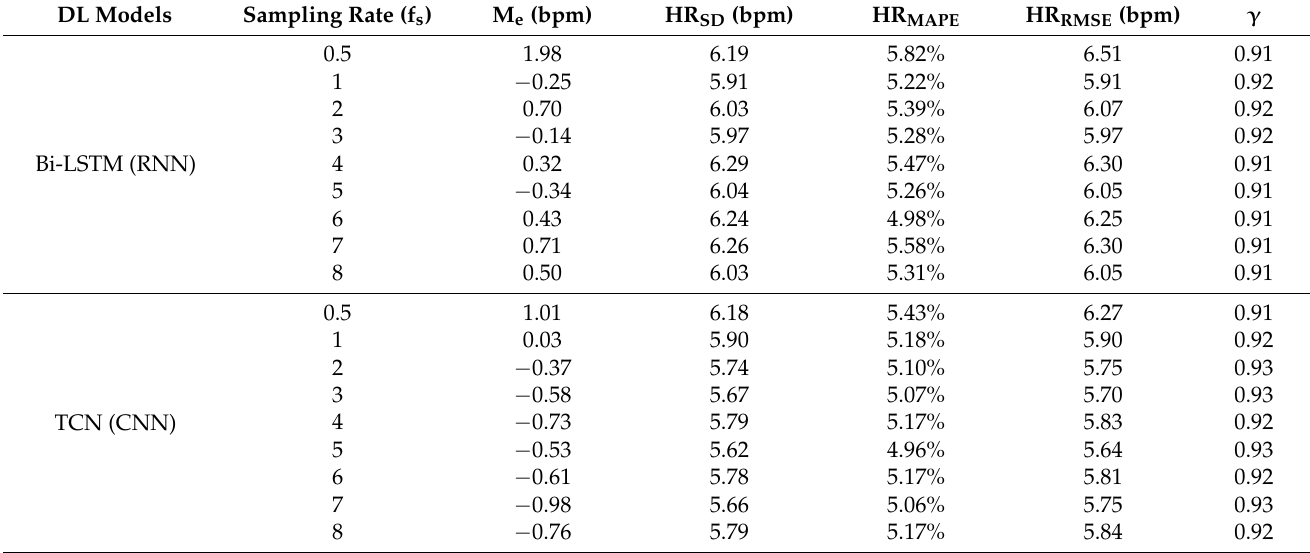
Table 1. iHR estimation performance comparisons on the MIT-BIH Normal Sinus Rhythm Database at various sampling frequencies (64–1024